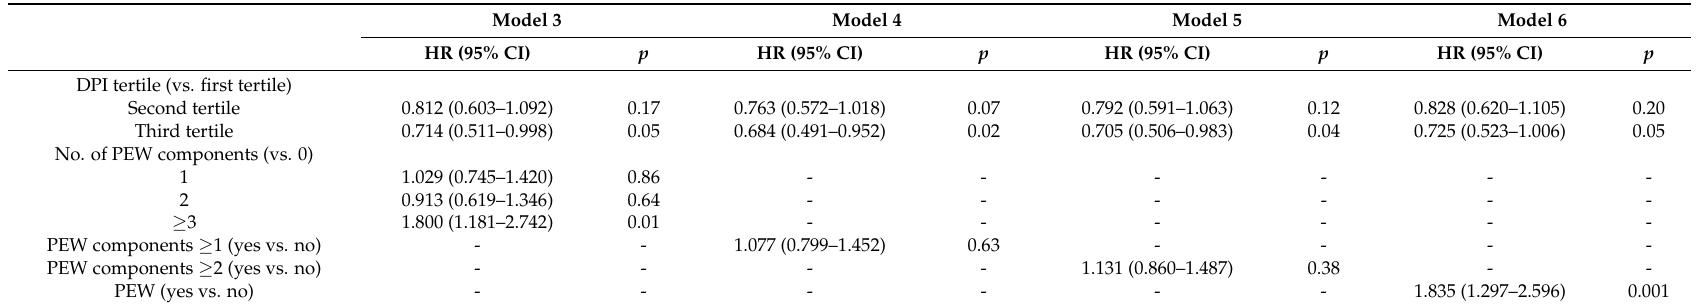
Table 3. Sensitivity analysis based on different protein-energy wasting (PEW)